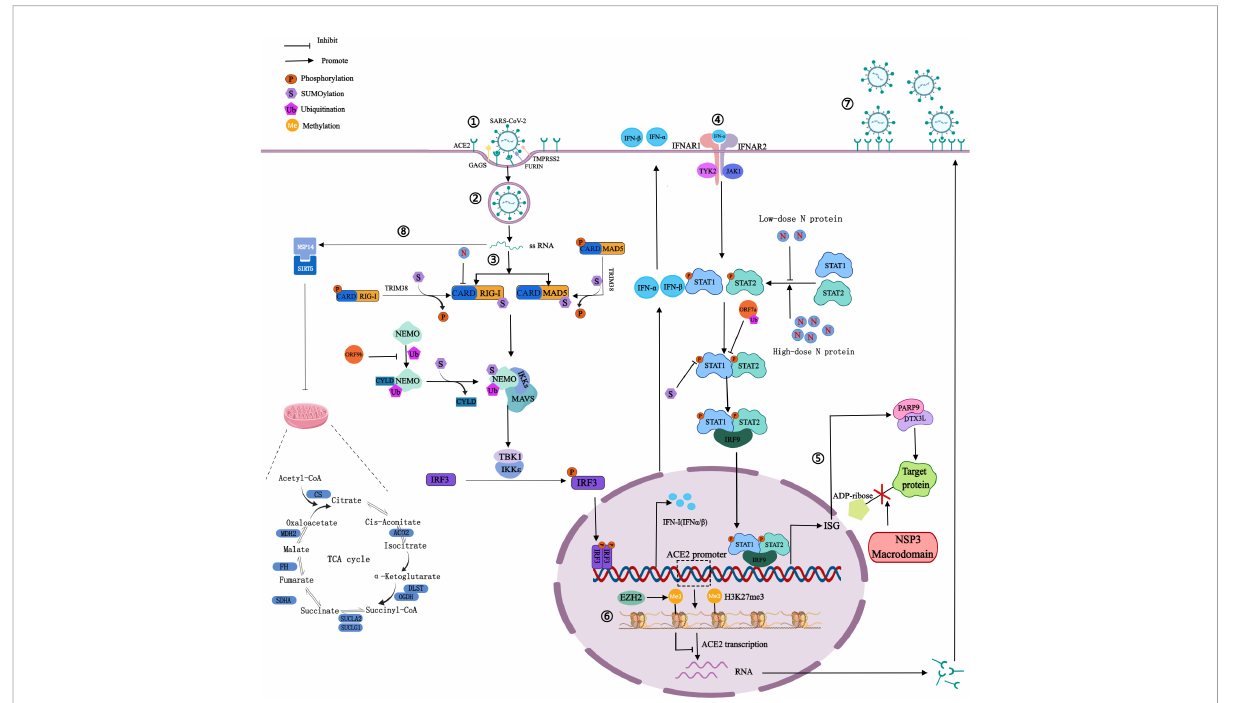
FIGURE 2 Mechanism of SARS-CoV-2 on PTMs of host proteins. ① Spike proteins recognize and bind to host cell surface receptors (ACE2, GAGS), TMPRSS2 and furin cleave the S1 and S2 subunits. ② Membrane fusion. ③ The production of IFN: RIG-I and MAD5 recognize viral RNA and expose the CARD domain, through which RIG-I or MDA5 could interact with MAVS to activate the inhibitor of I k B ϵ and TBK1, thereby phosphorylating IRF3 and phosphorylated IRF3 enters into the nucleus to activate IFN-I gene expression. ④ The signaling process of IFN: Secreted IFN- a / b binds and activates JAK1 and TYK2, then they phosphorylate STAT1 and STAT2. Phosphorylated STAT1 and STAT2 can form heterodimers, which then bind to IRF9 to form a transcriptional complex IRF3 that translocates to the nucleus to induce the expression of ISG. ⑤ NSP3 macrodomain reverses PARP9/DTX3L-dependent ADP-ribosylation of host proteins induced by IFN signaling. ⑥ H3K27 can be methylated by EZH2 to form H3K27me3, then inhibits ACE2 expression in host cells. ⑦ Highly expressed ACE2 receptors increase the risk of SARS-CoV-2 infection. ⑧ NSP14 interacts with SIRT5 to reduce the level of protein succinylation in the host TCA cycle. The blue bars represent the metabolic enzymes in the TCA